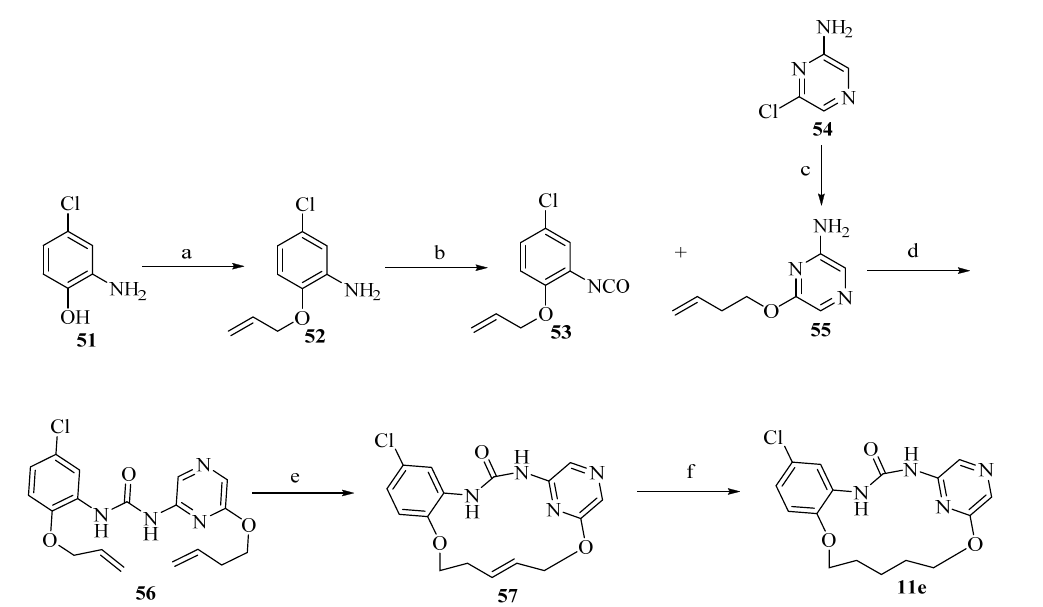
Scheme 5. Reagents and conditions: (a) allyl bromide, K 2 CO 3 , acetone, rt, 65%; (b) phosgene, tolu- ene, 110 °C, quantitative yield; (c) 3-buten-1-ol, NaH, dioxane, 100 °C, 31%; (d) toluene, 110 °C,